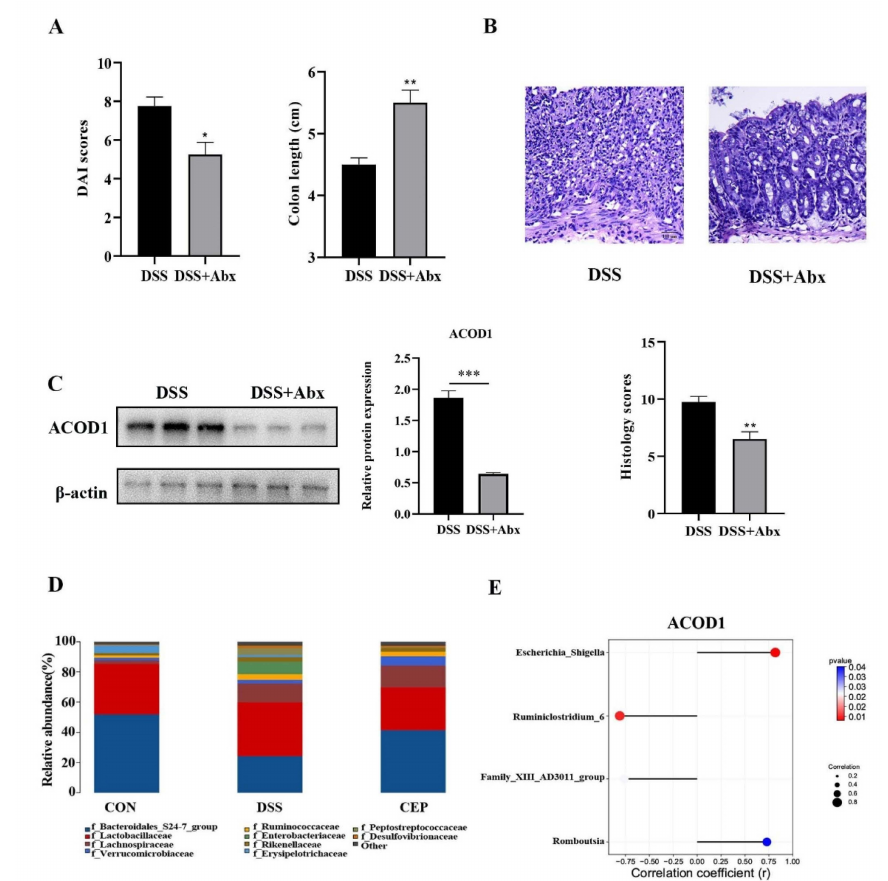
Figure 4. CEP acts on gut microbiota to regulate ACOD1 expression. ( A ) DAI score between the DSS group and DSS+ABX group; ( B ) H&E staining of mice colon tissue (X100); the histology score; ( C ) the protein expression ACOD1 assessed by WB; the histology score; ( D ) relative abundance of gut microbiota at the family levels; ( E ) correlation analysis between ACOD1 and gut microbiota. * p < 0.05; ** p < 0.01; *** p <